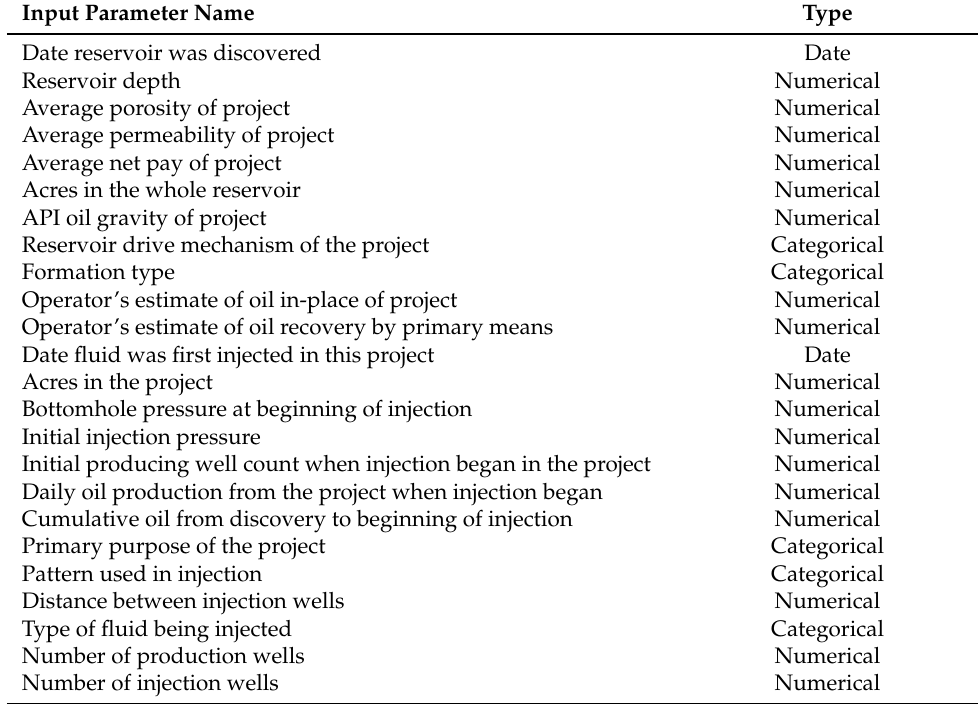
Table 1. List of input parameters.